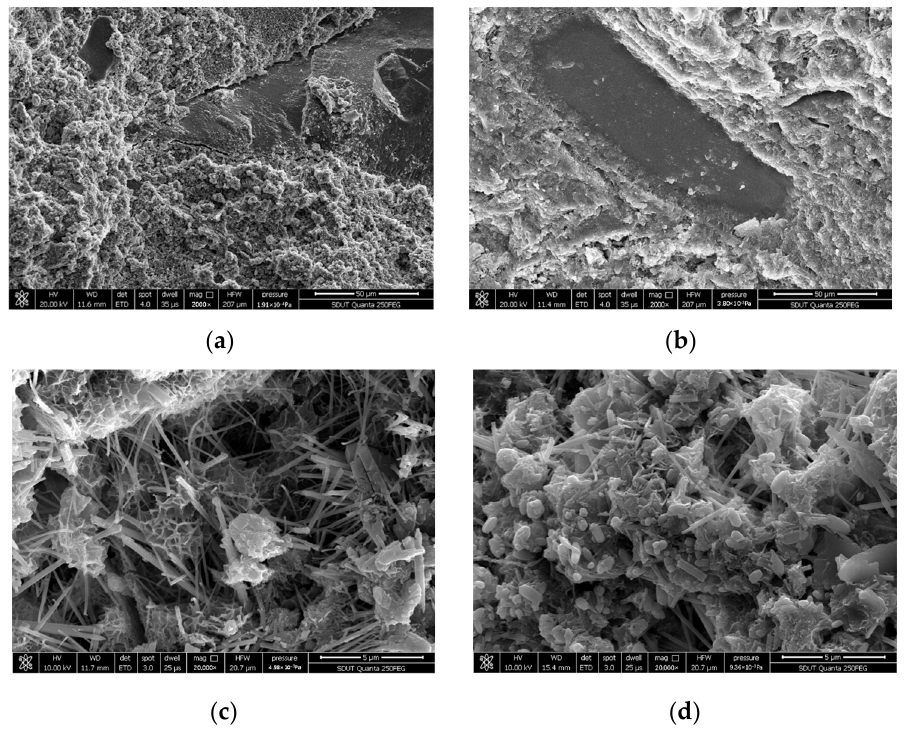
Figure 7. The SEM diagram of influence for fine aggregate on concrete: ( a ) NAC (2000×); ( b ) CSAC (2000×); ( c ) NAC (20,000×); ( d ) CSAC (20,000×).